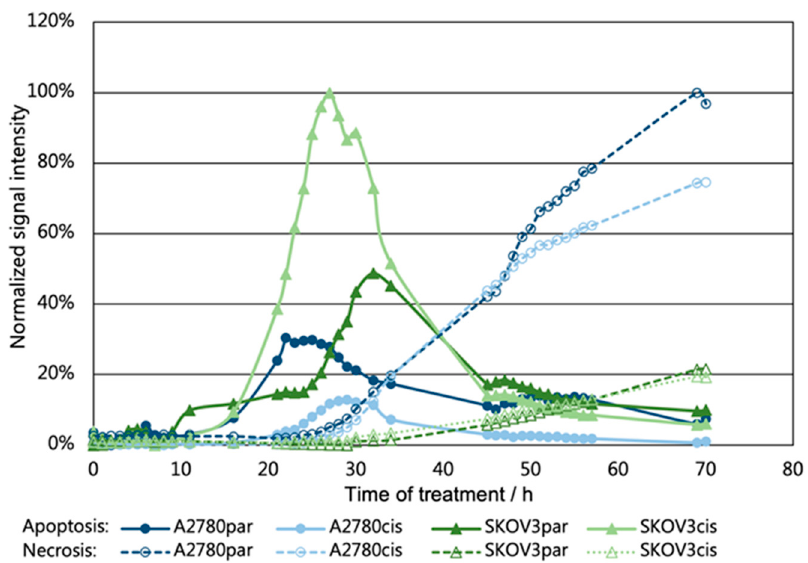
Figure 3. Real-time measurement of apoptosis and necrosis under treatment with 3 μ M complex 7 .